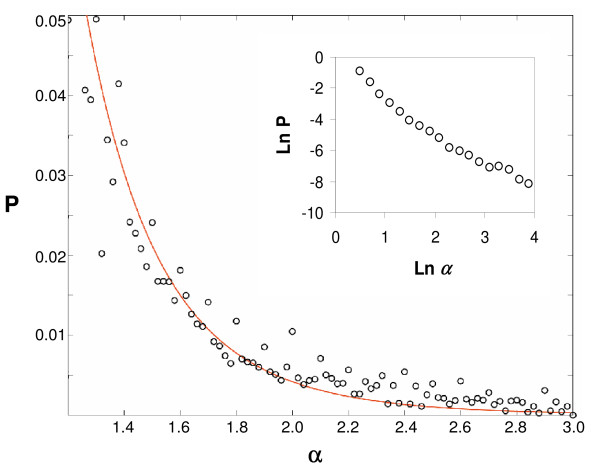
Distribution the values of α extracted from CHIRBASE [75] (circles) and a fit (solid line) as described in the Methods with σε = 0.8 (Eq. 6 and ref. 69). CHIRBASE database holds experimentally obtained retention data (about 60,000 values at 2003) which were transformed into thermodynamic association constants according to published relationships derived for quantitative affinity chromatography [87-89]. The insert shows a double logarithmic transformation of the data over a larger range, with a limiting linear slope of -1.98 and R = 0.99, in line with a lognormal distribution tail.